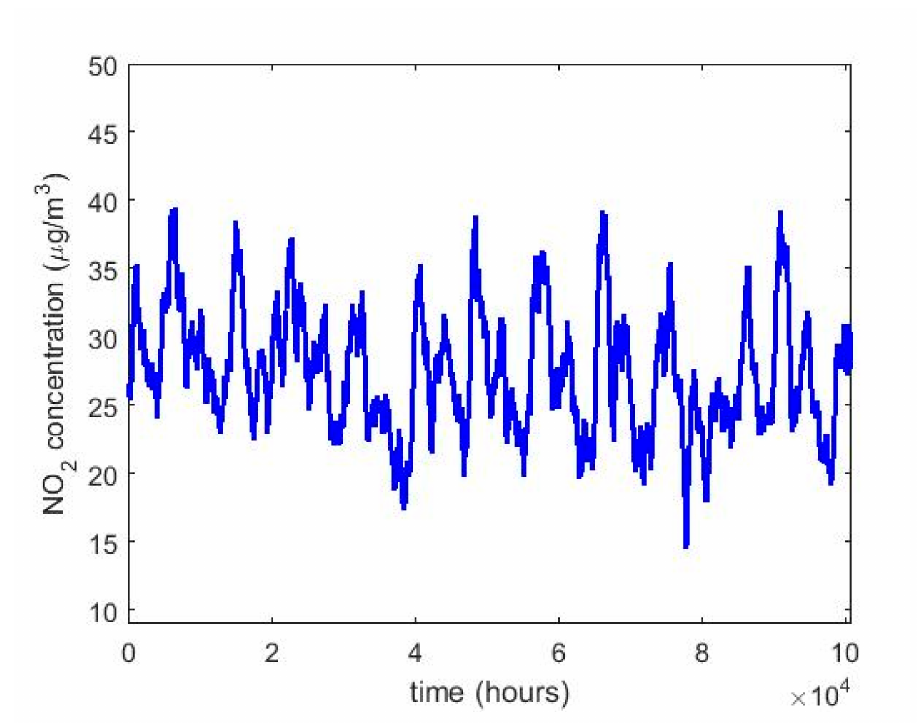
Figure 2. Moving average of the sequence consisting of the NO 2 concentration measurements from 1 January 2008 to 31 December 2019.